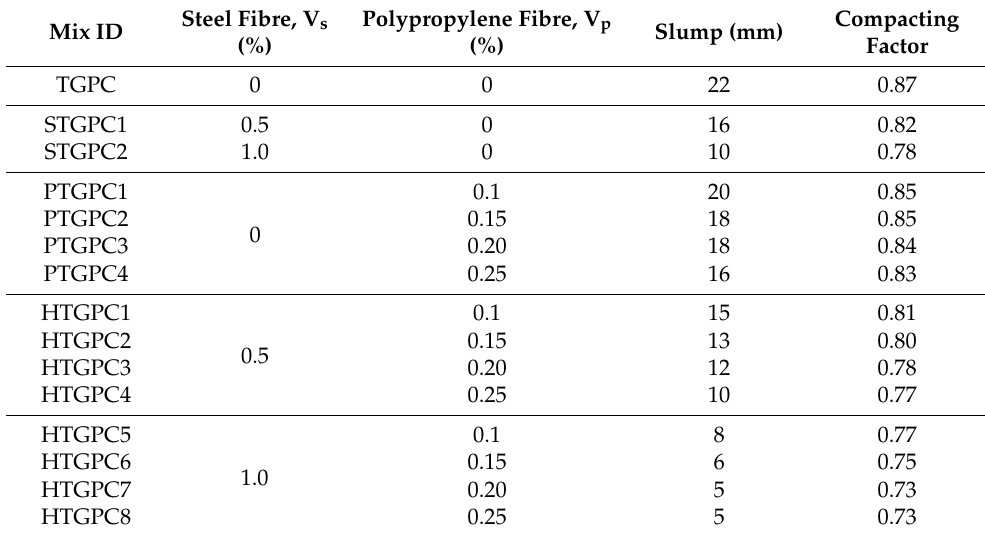
Table 6. Test results of fresh